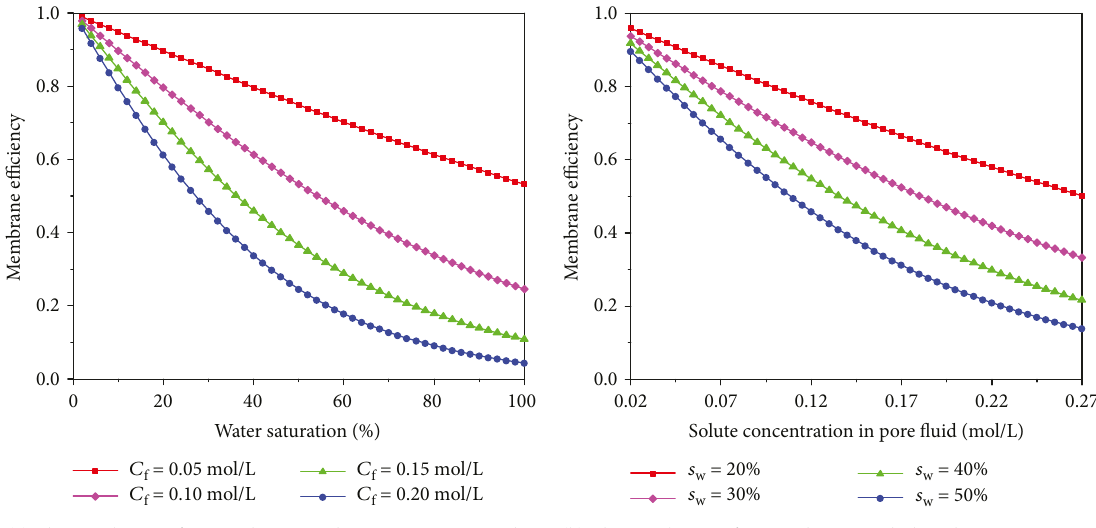
Figure 6: E ff ect of solute concentration in pore fl uid on membrane e ffi ciency under unsaturated conditions.